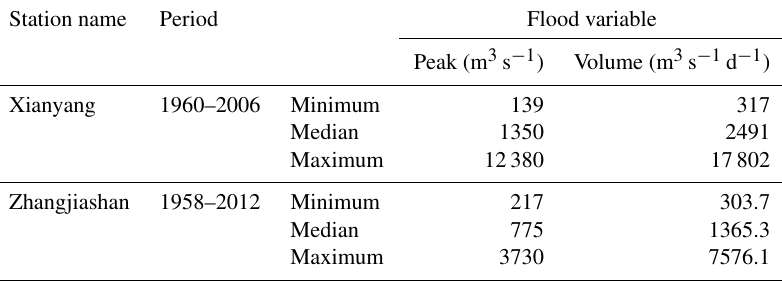
Table 1. Flood characteristics for different stations.